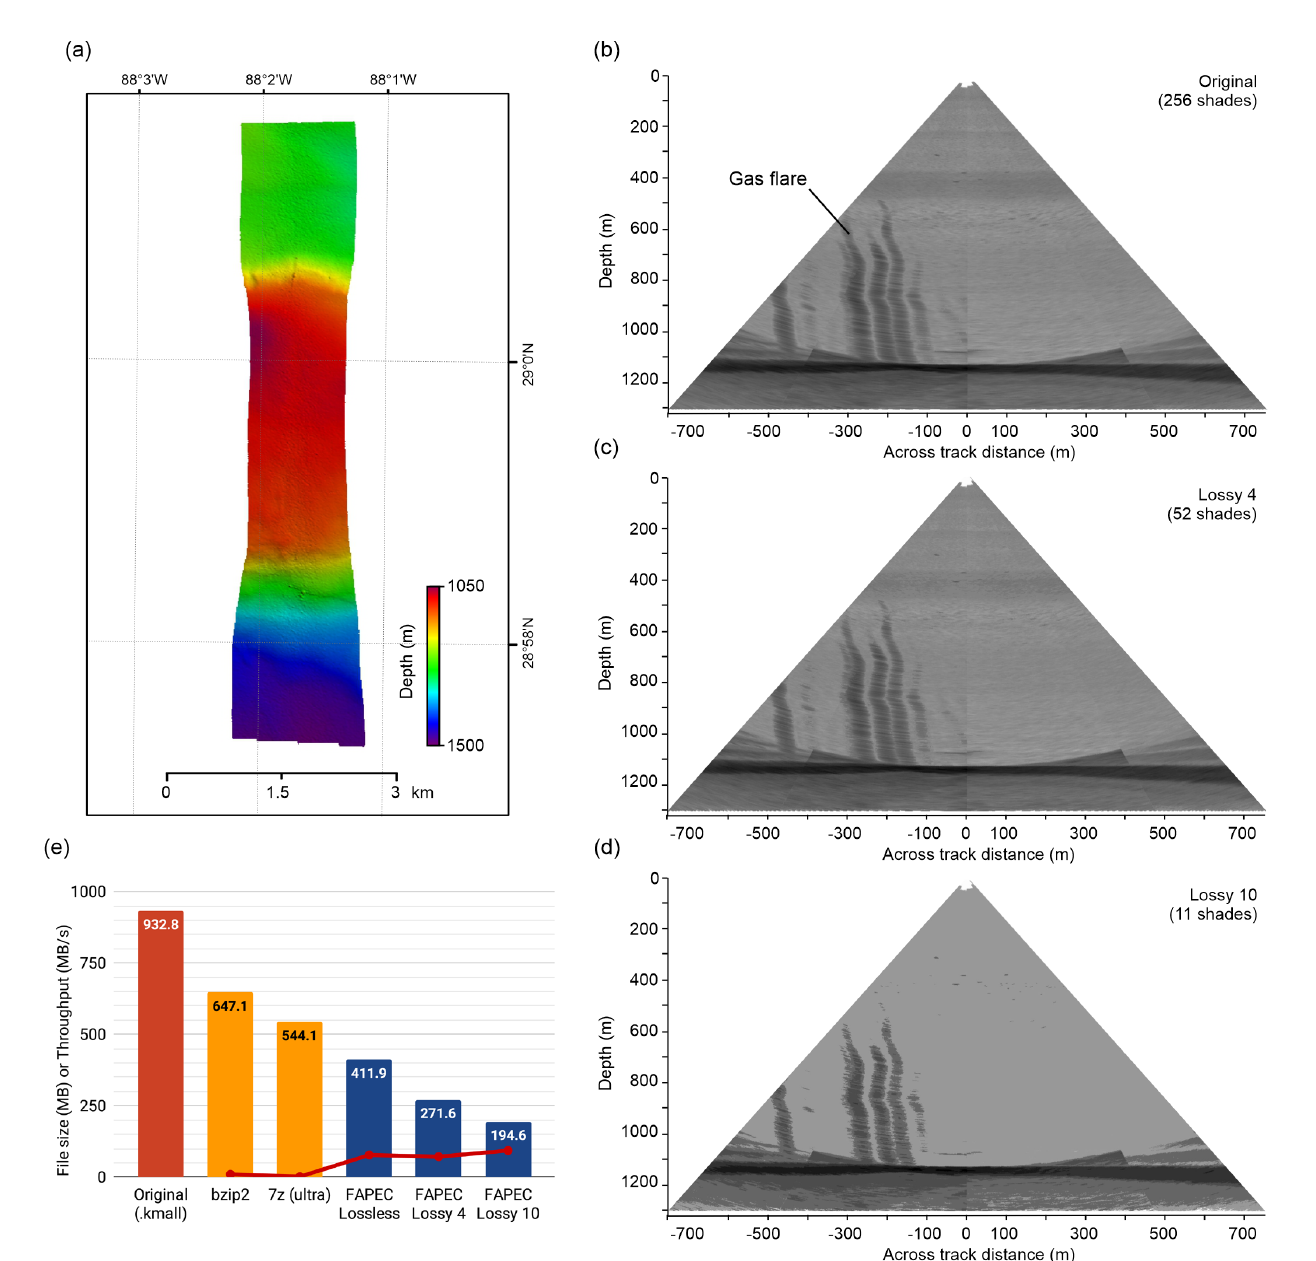
Figure 15. Kongsberg EM304 survey in the Gulf of Mexico. ( a ) Bathymetry. ( b – d ) Mid-water backscatter showing gas flares at different levels of lossy compression. ( e ) Original and compressed file sizes. The red line and dots indicate the compression rate. Data courtesy of Fugro USA